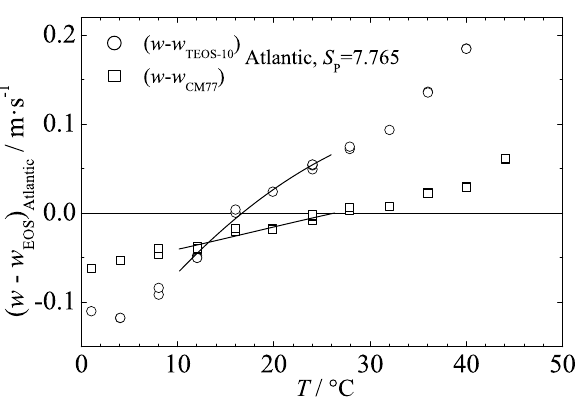
Figure 4. Time-of-flight sensor output relative to speed of sound calculated with TEOS-10 and Chen and Millero (1977) equations of state, as an example for the North Atlantic seawater sample with S P = 7.765 (laboratory measurements). The lines show polynomial fits used for interpolation to extract values according to the in situ temperatures of the Baltic field